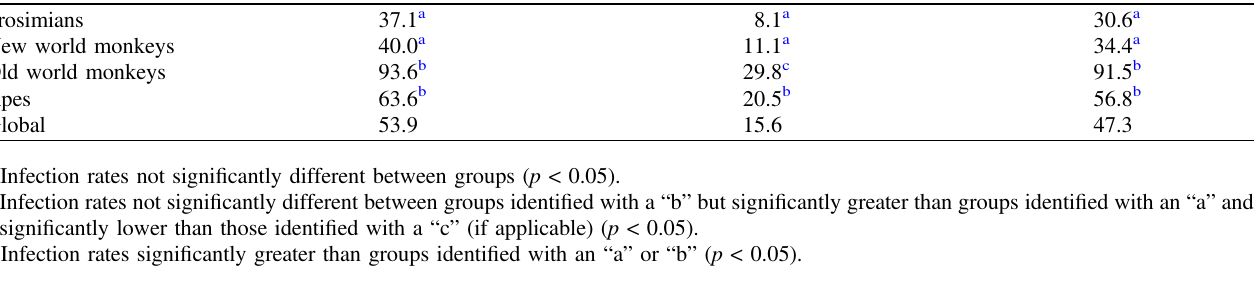
Table 1. Overall and group-speci fi c global, helminth and protozoa infection rates. Group